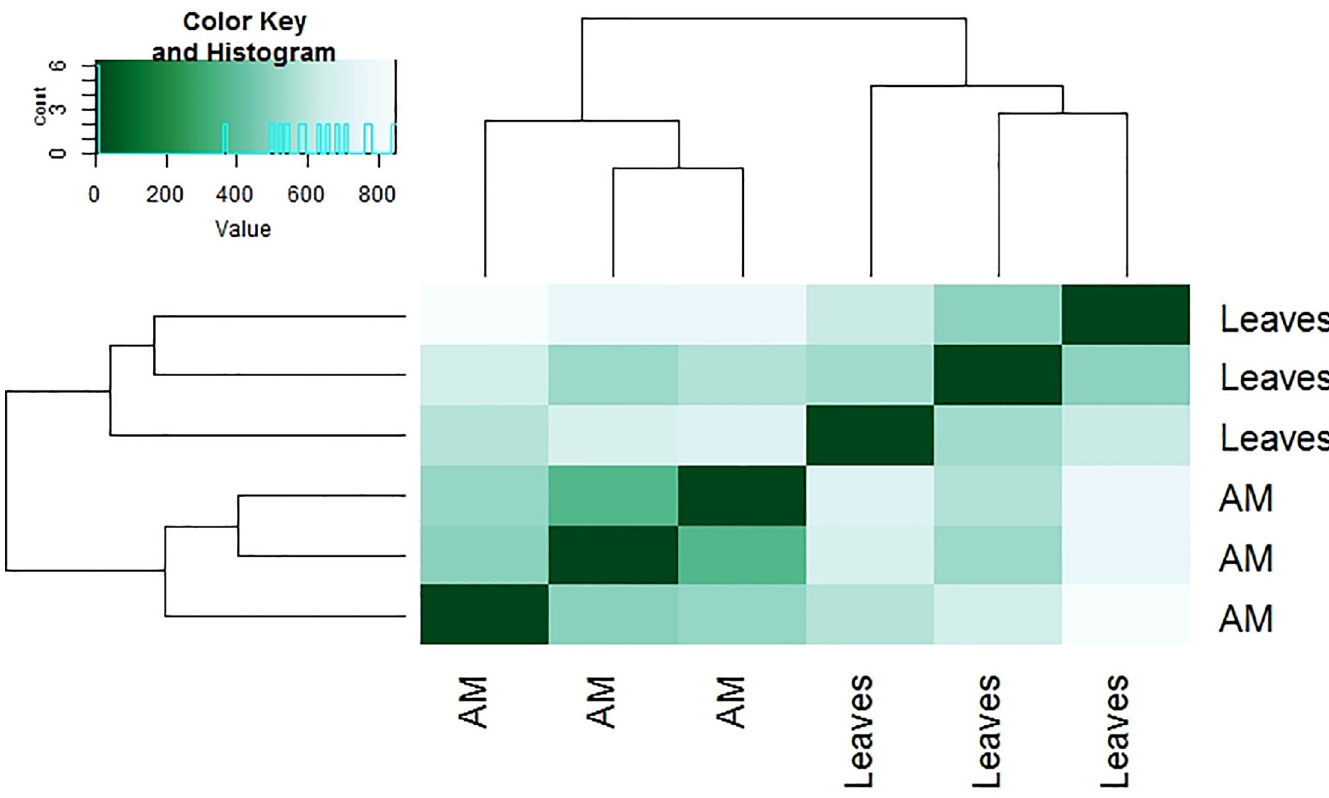
Fig 6. Comparisons of transcriptional profiles across samples. Heat-map showing hierarchical clustering resulting from a pairwise comparison of transcript expression levels. Clustering is represented between three separate biological replicates of leaves and apical meristematic (AM) tissue, respectively.